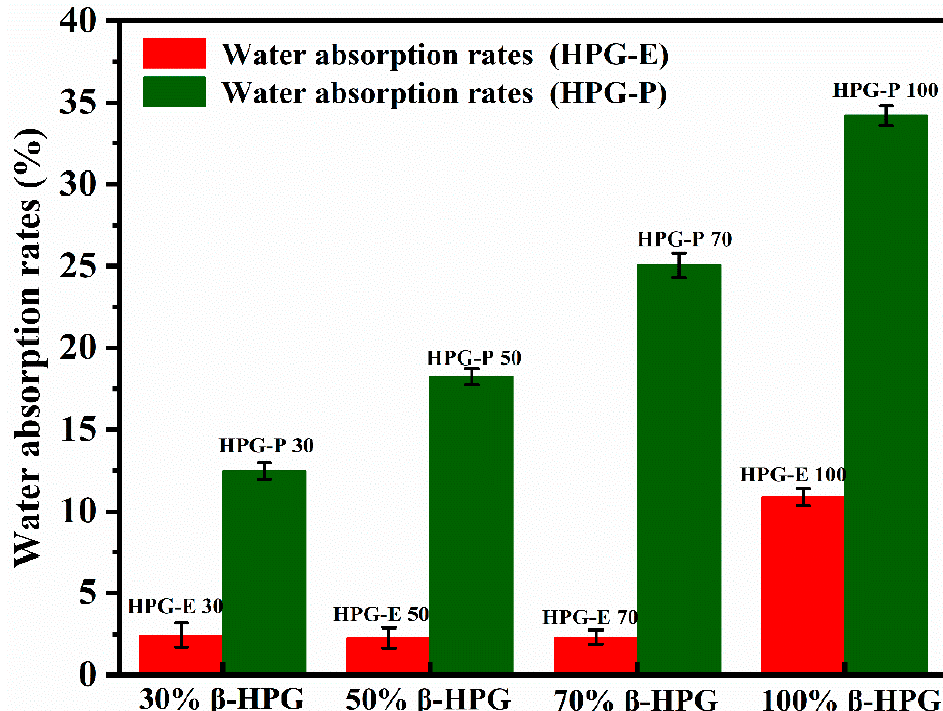
Figure 7. Water absorption properties of the as-prepared specimens.